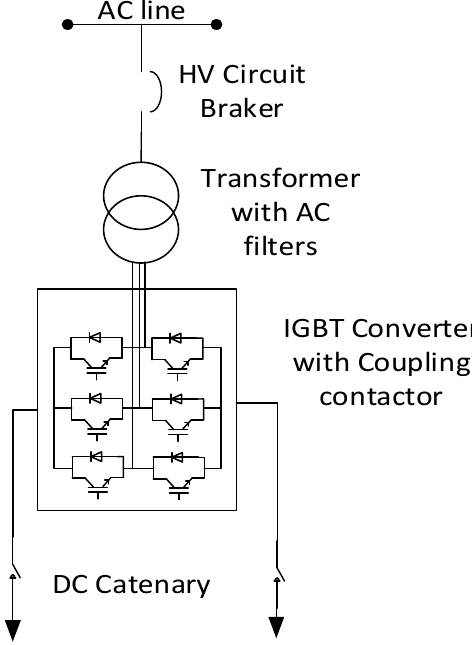
Figure 19. Updated HESOP Configuration [127].